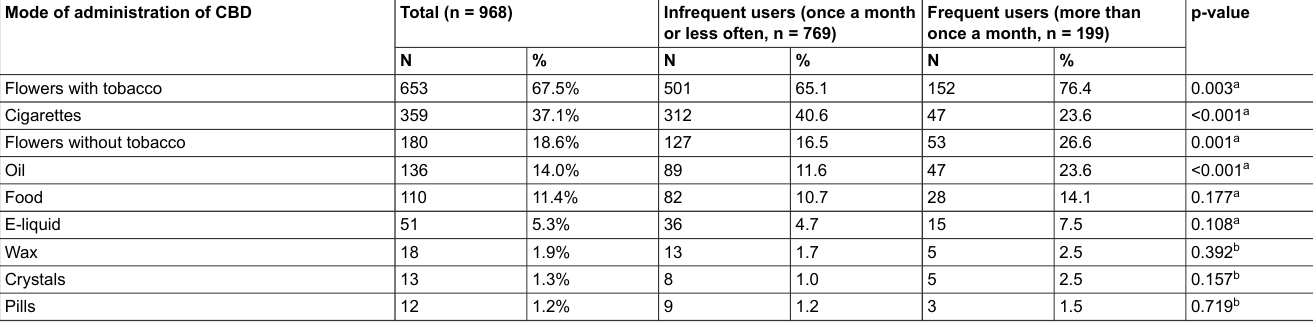
Table 2: Modes of administration of CBD among users in the past 12 months(n = 968). Mode of administration of CBD